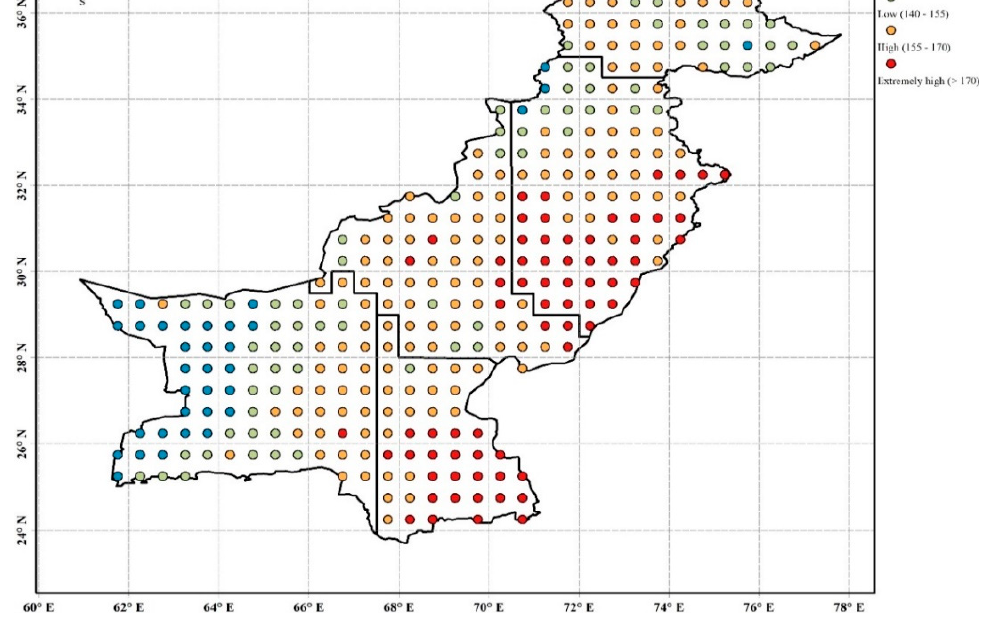
Figure 7. Drought count at each grid cell.